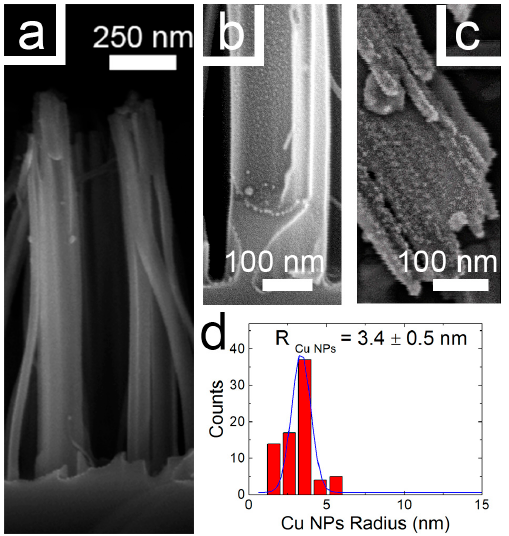
Figure 3. ( a ) Cross-section SEM image of Cu decorated SiNWs; ( b ) SEM microscopy displaying the NW bottom decorated with CuNPs; ( c ) SEM microscopy displaying the tips of an ensemble of Cu decorated SiNWs; ( d ) Statistical analysis of the CuNPs radius measured for the top section of the sample.